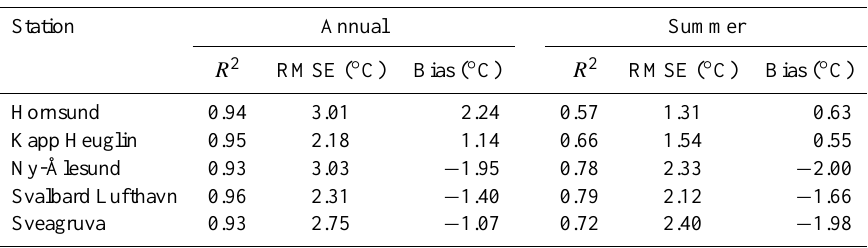
Table 3. 1979–2013 mean annual and summer correlation ( R 2 ), RMSE and bias ( ◦ C) between the ERA-Interim reanalysis and the observed temperature.